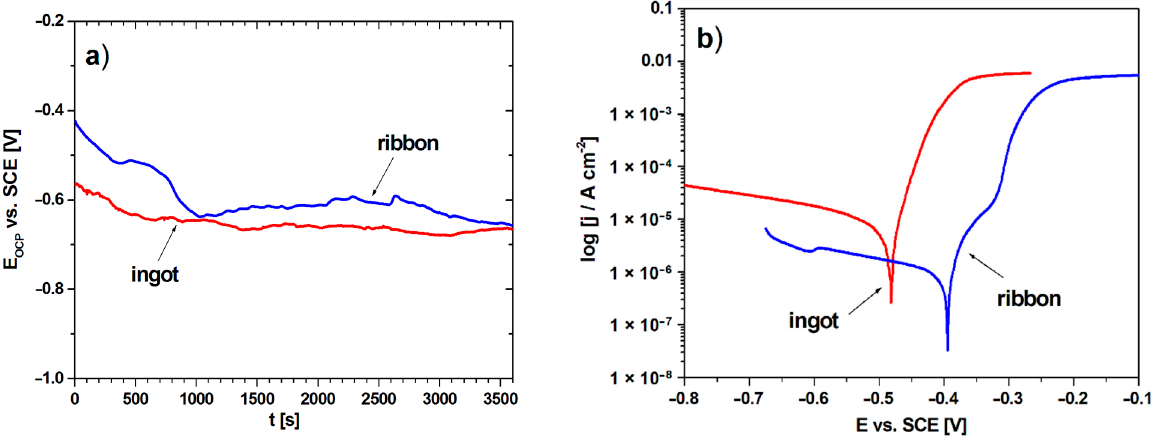
Figure 8. Variation in the open-circuit potential with time ( a ) and polarization curves ( b ) for ingot and ribbon in 3.5% NaCl solution at 25 °C. Table 3. The polarization tests of Al 65 Cu 20 Fe 15 alloy in the form of an ingot and ribbon in 3.5%